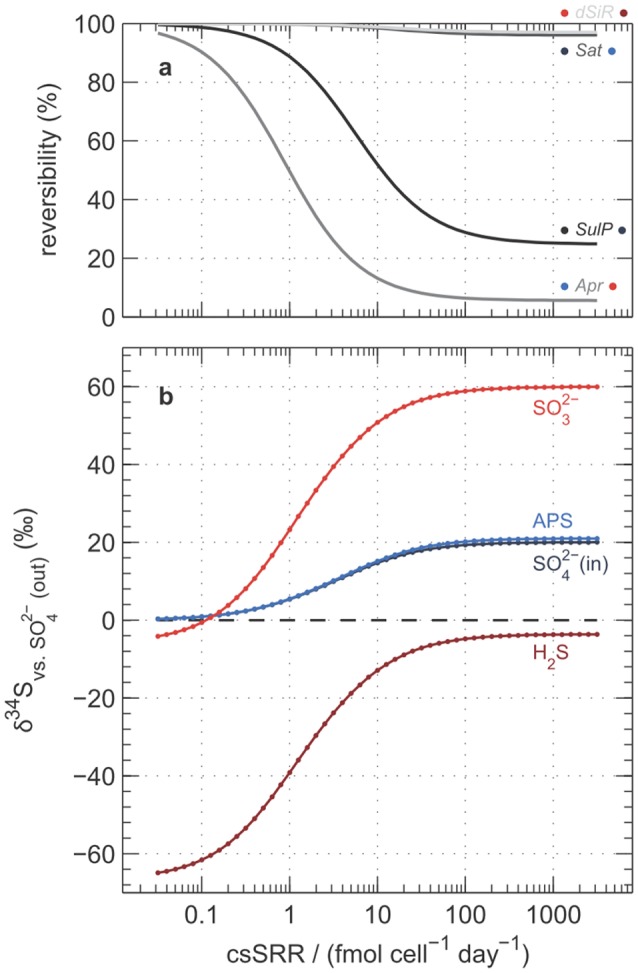
Model predictions for (a) reversibility of key reactions and (b) isotopic composition of intracellular sulfur compounds. Calculations follow Wing and Halevy (2014) and assumptions are identical to those used in Figure 7. Labels in panel (a) indicate the enzyme responsible (see Equations A1–A4), and coloring of dots to the left and right correspond to colors in (b) of the sulfur-containing reactants and products, respectively. Predicted δ34S values in (b) are expressed relative to extracellular sulfate at steady-state.